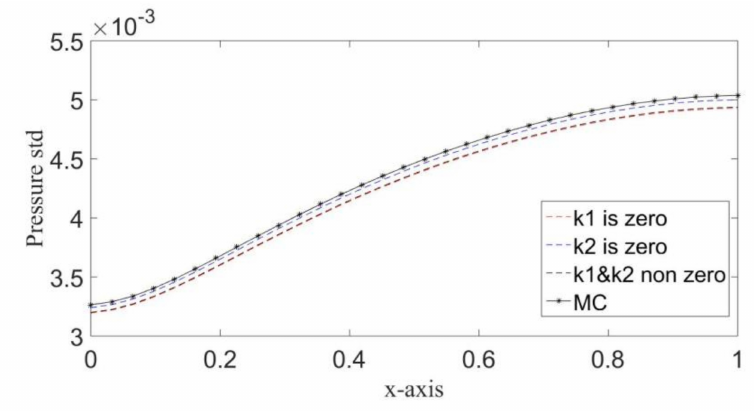
Figure 4. Comparing the pressure standard deviation resulting from MC and PCE